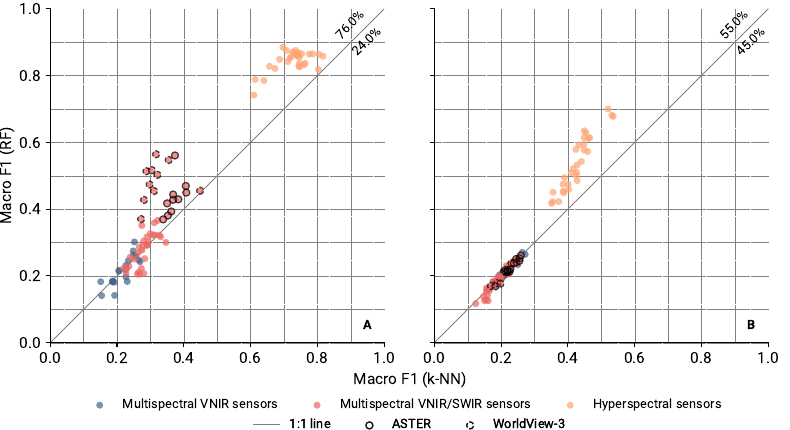
Figure 7. Macro F1 scores achieved with k-NN and RF for different types of sensors using all background surfaces, while ( A ) is the result using simulated signals without noise and ( B ) is with added 5% noise. The percentages in the upper right corners indicate the proportion of cases in which the respective classifier achieved better results than the